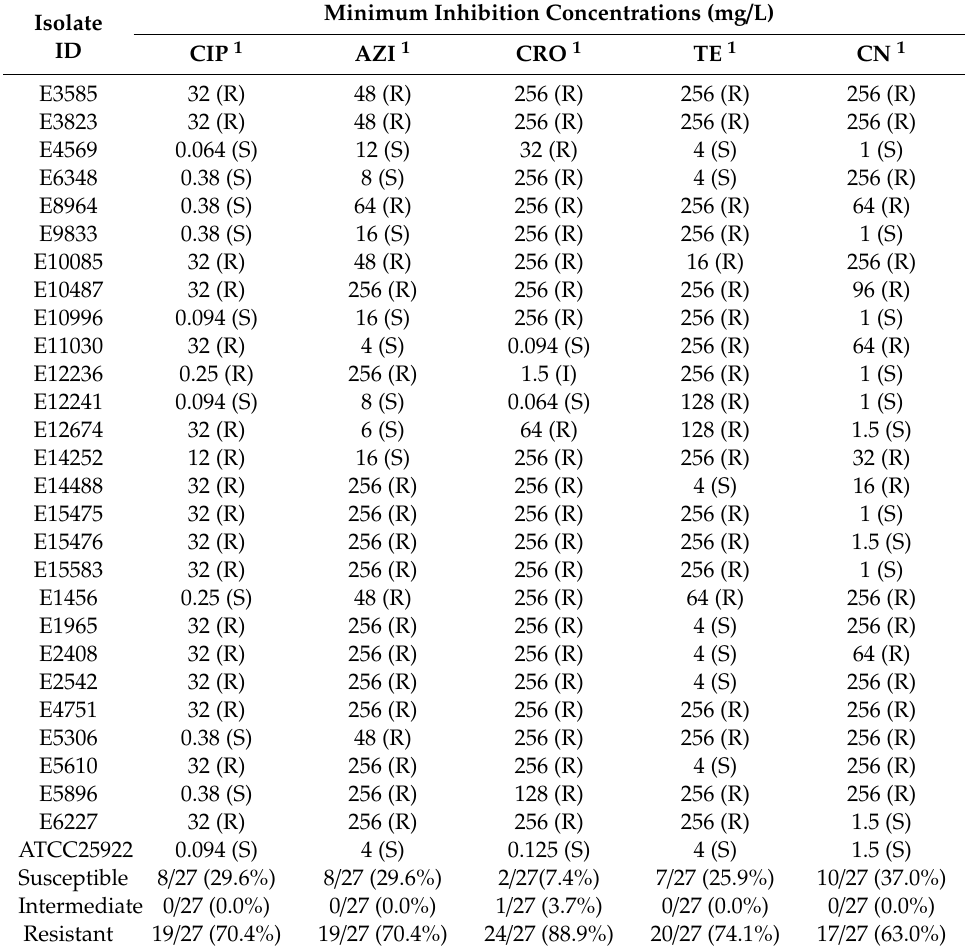
Table 1. Minimum inhibition concentrations (MICs) and antimicrobial resistance of ATCC 25922 and 27 clinical isolates used in this